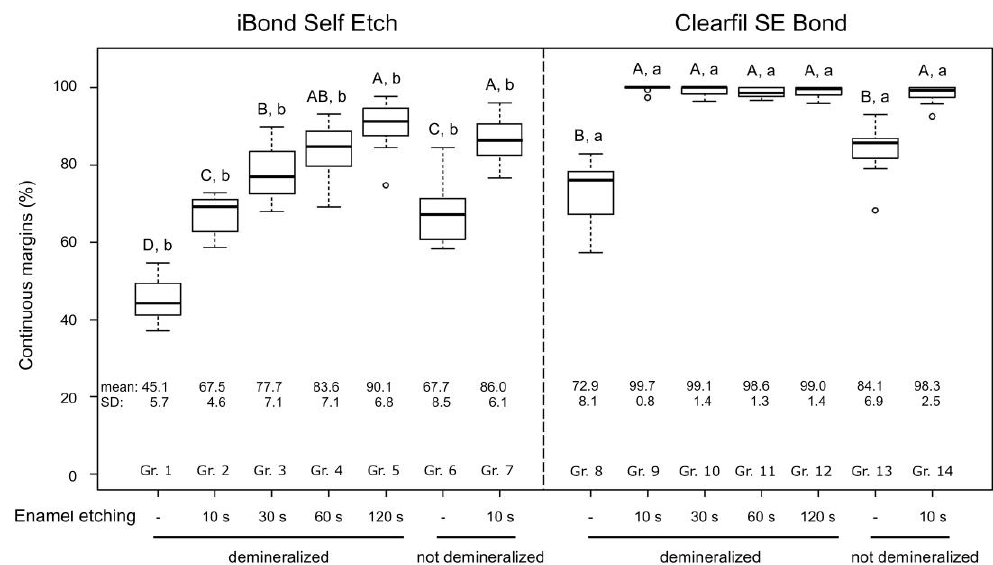
Figure 2. Continuous margins (%) of the composite restorations in demineralized and not demineralized (sound) enamel after application of the tested adhesive systems (iBond Self Etch, Clearfil SE Bond) with different enamel etching times. The thick lines within the boxplots represent the medians, whereas the upper and lower margins of the boxes are equivalent to the 75% and 25% quartiles, respectively. The whiskers illustrate 1.5 × interquartile range (IQR), or maxima and minima of the distribution if below 1.5 × IQR. Circles represent the outliners. Significant differences between groups within each adhesive system are indicated with different capital letters (post-hoc Conover tests, p < 0.05), while significant differences between analogue experimental groups of the two adhesives are indicated with different small letters (Wilcoxon rank sum test, p < 0.05). SD: standard deviation.